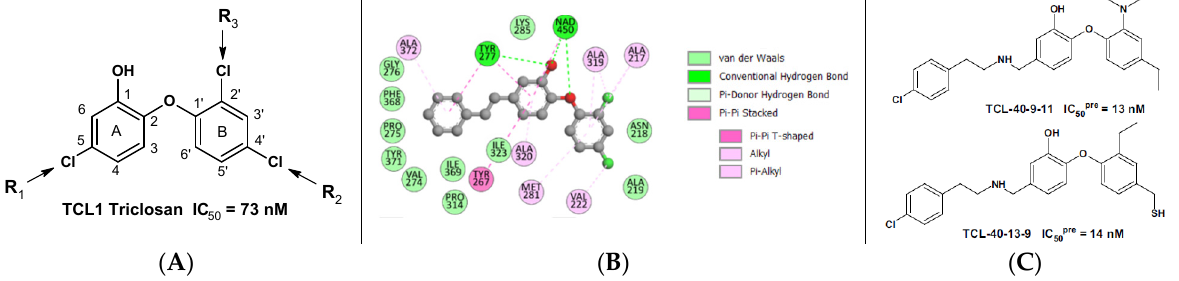
Figure 1. Chemical structure of TCL1 triclosan. ( A ) scaffold atom numbering and the positions of the R-group are indicated. ( B ) Structure of TCL11 (IC 50 = 76 nM, Table 1) and 2D interaction diagram with residues from the active site of Pf ENR (PDB entry 2OOS) [21]. Atom colouring: C—grey, O—red, Cl—green. ( C ) triclosan analogues that were previously predicted to be potent inhibitors of Pf ENR [6,32]. Table 1. Training and validation sets of TCL inhibitors used for the preparation of QSAR models of Pf ENR inhibition. The experimental activities were taken from [21,23,25,27].